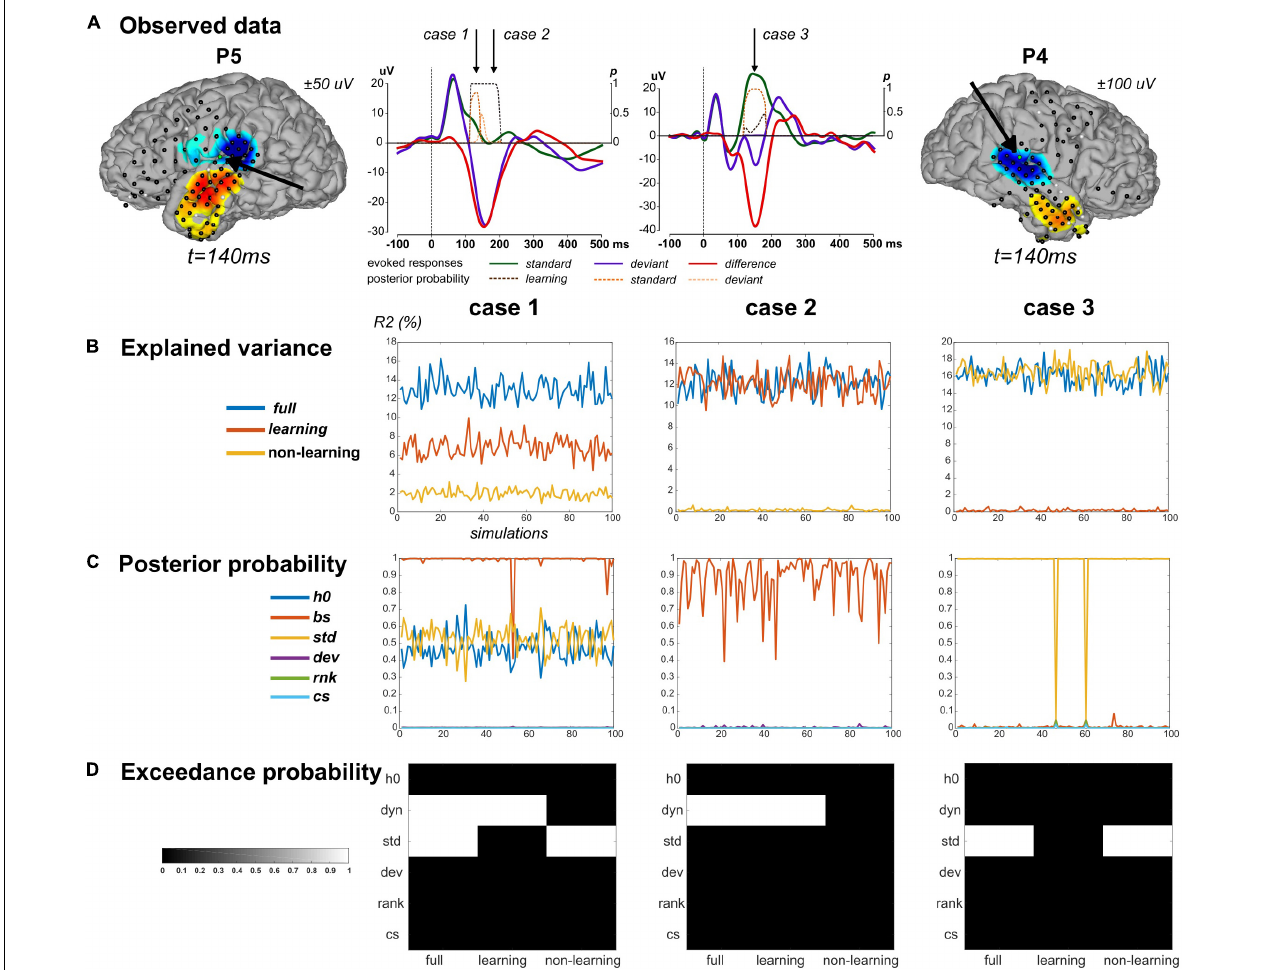
FIGURE 3 | Simulation findings. (A) Simulations were based on parameter values inferred from ECoG data fitting. Three cases were considered. Case 1 and Case 2 concern one sensor in P5, highlighted on the cortical surface (same display as in Figure 5A ). Corresponding evoked responses at this sensor (average response across contexts UC and PC), for standard (green), deviant (purple) stimuli, and their difference (red), and posterior probabilities at peri-stimulus samples for the learning (brown), standard (orange) and deviant (yellow) regressors suppress (color code provided on the figure). Case 3 derived from one sensor in P4 (right). Cases are presented in columns in panels (B–D) . (B) Percentage of explained variance when fitting the full model to 100 simulated data ( x -axis) generated from the full (blue), learning (red) and non-learning (yellow) models. (C) Posterior probability of each regressor (following the legend provided) for each simulated data with the full model. (D) Posterior exceedance probability for each regressor ( y -axis) computed from family-level inference (RFX) performed over the 100 simulations generated from the full, learning and non-learning models ( x